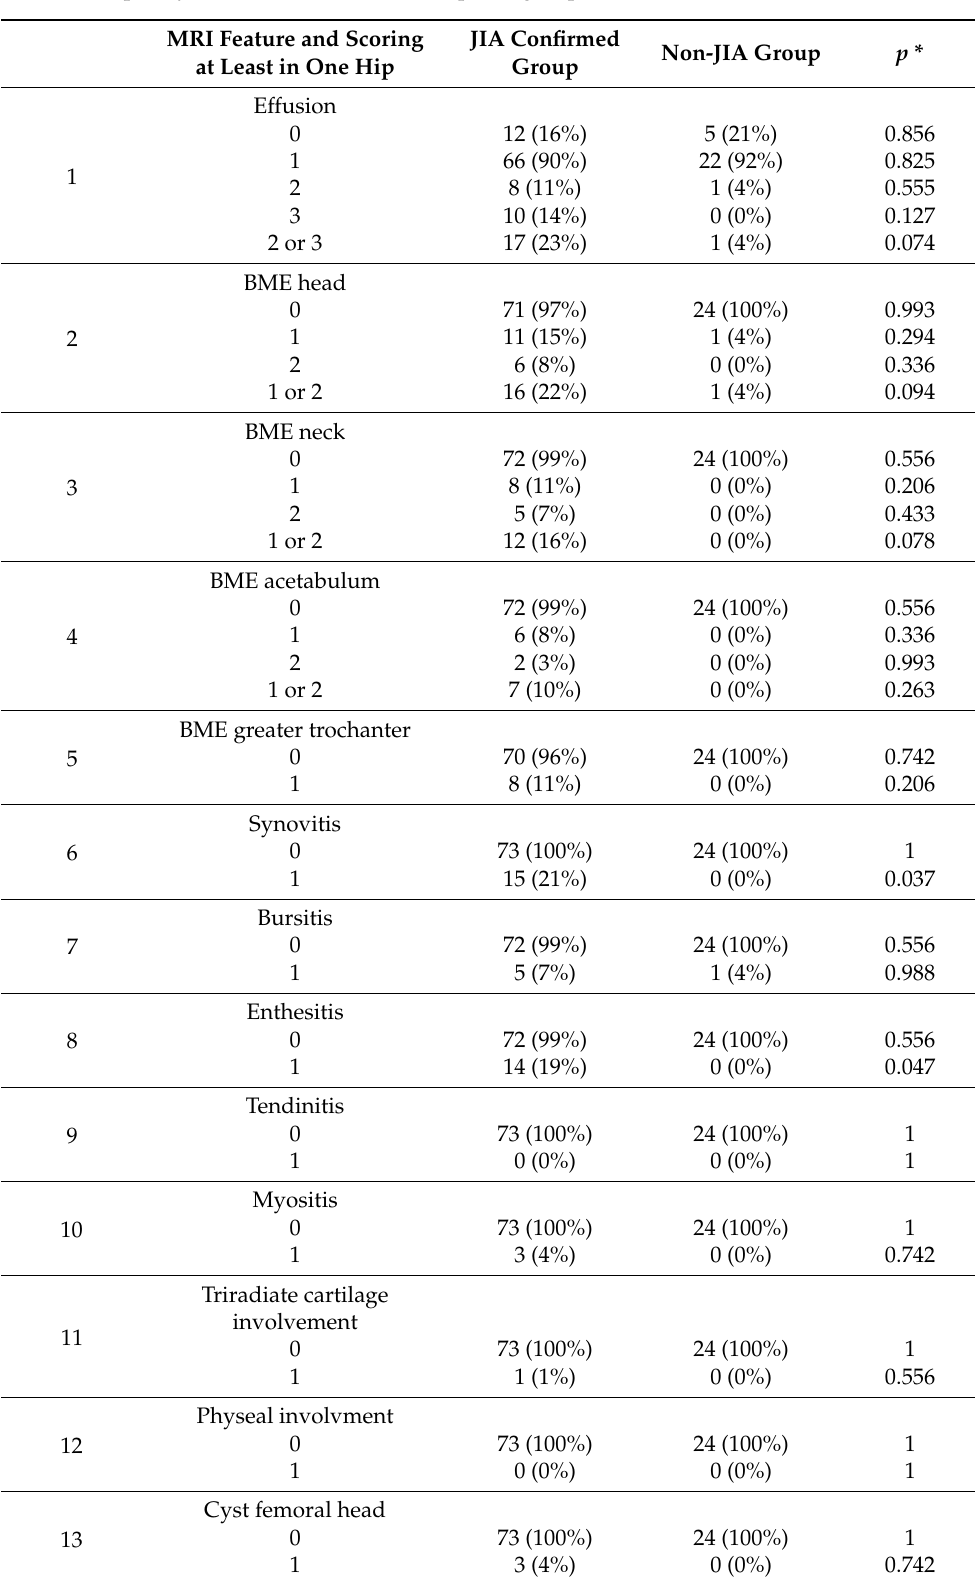
Table 3. Frequency of MRI features in the compared